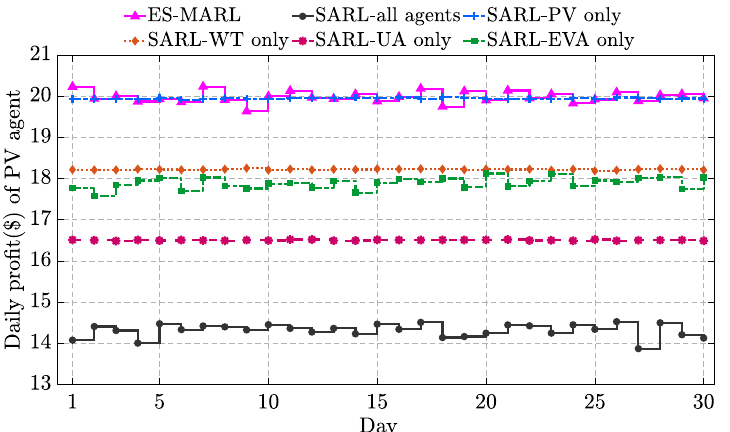
Figure 5. PV agent’s daily profit in different RL configurations.